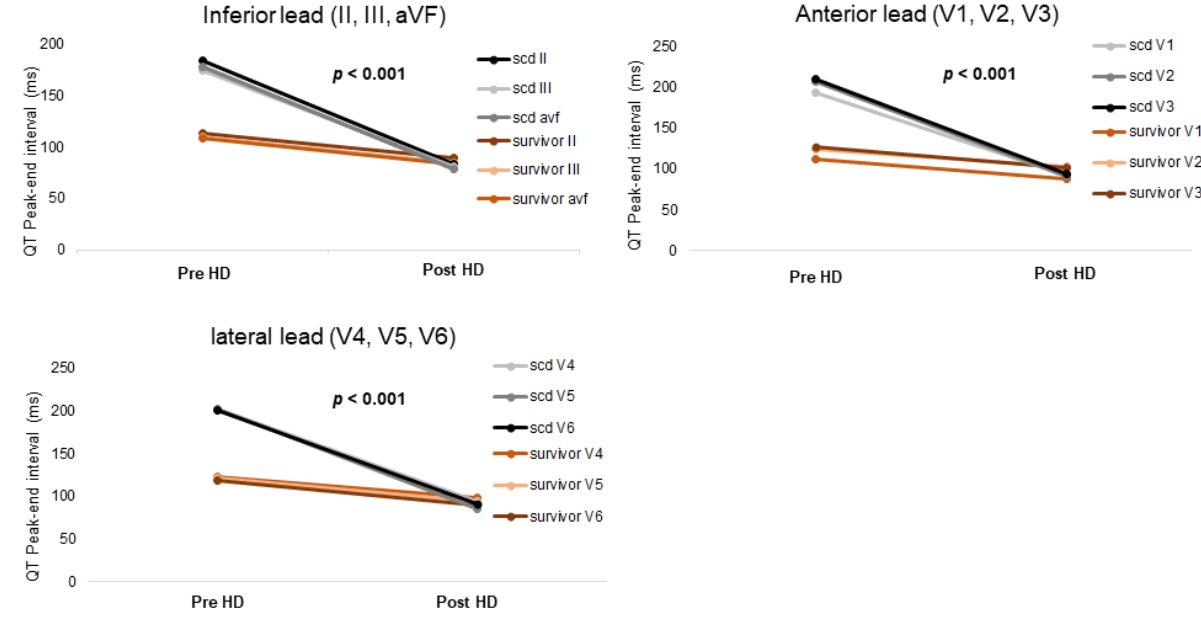
Figure 2. Comparison of electrocardiography (ECG) change before and after hemodialysis (HD) using a linear mixed model. The change in QT peak-to-end (QTpe) interval before and after HD in the sudden cardiac death (SCD) group and the change in QTpe interval before and after HD in the survivor group were statistically significant. The SCD group showed a significantly larger change in the QTpe intervals of the inferior, anterior, and lateral leads after HD than the survivor group.